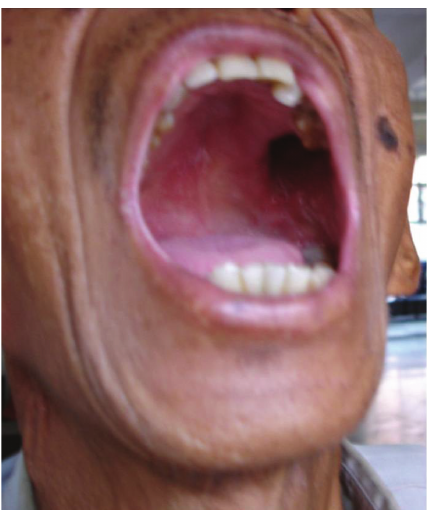
Figure 1: Ulcer in oral cavity a ff ecting upper left alveolus.